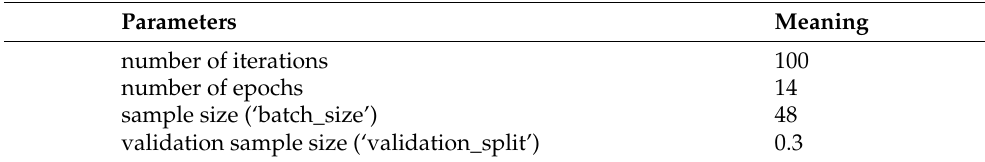
Table 5. Hyperparameter values for the CNN